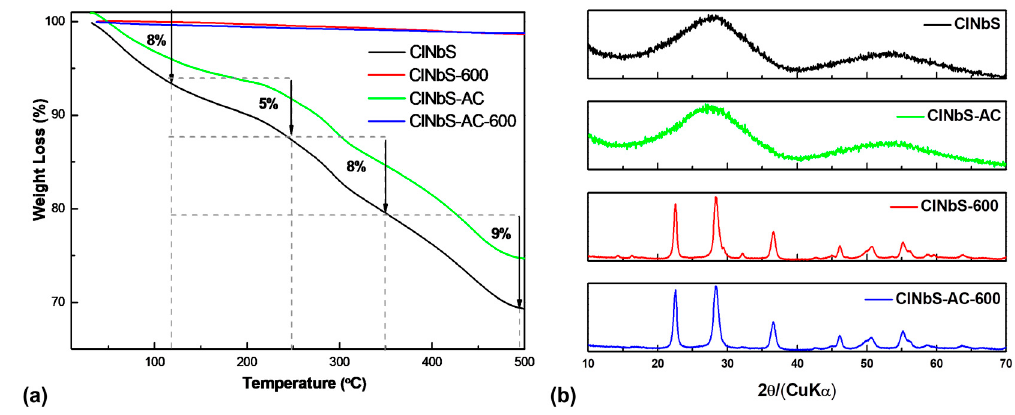
Figure 1. ( a ) Thermogravimetric curves for the catalysts under air atmosphere and ( b ) X ray diffraction patterns of ClNbS-600 and ClNbS-AC-600 catalysts.